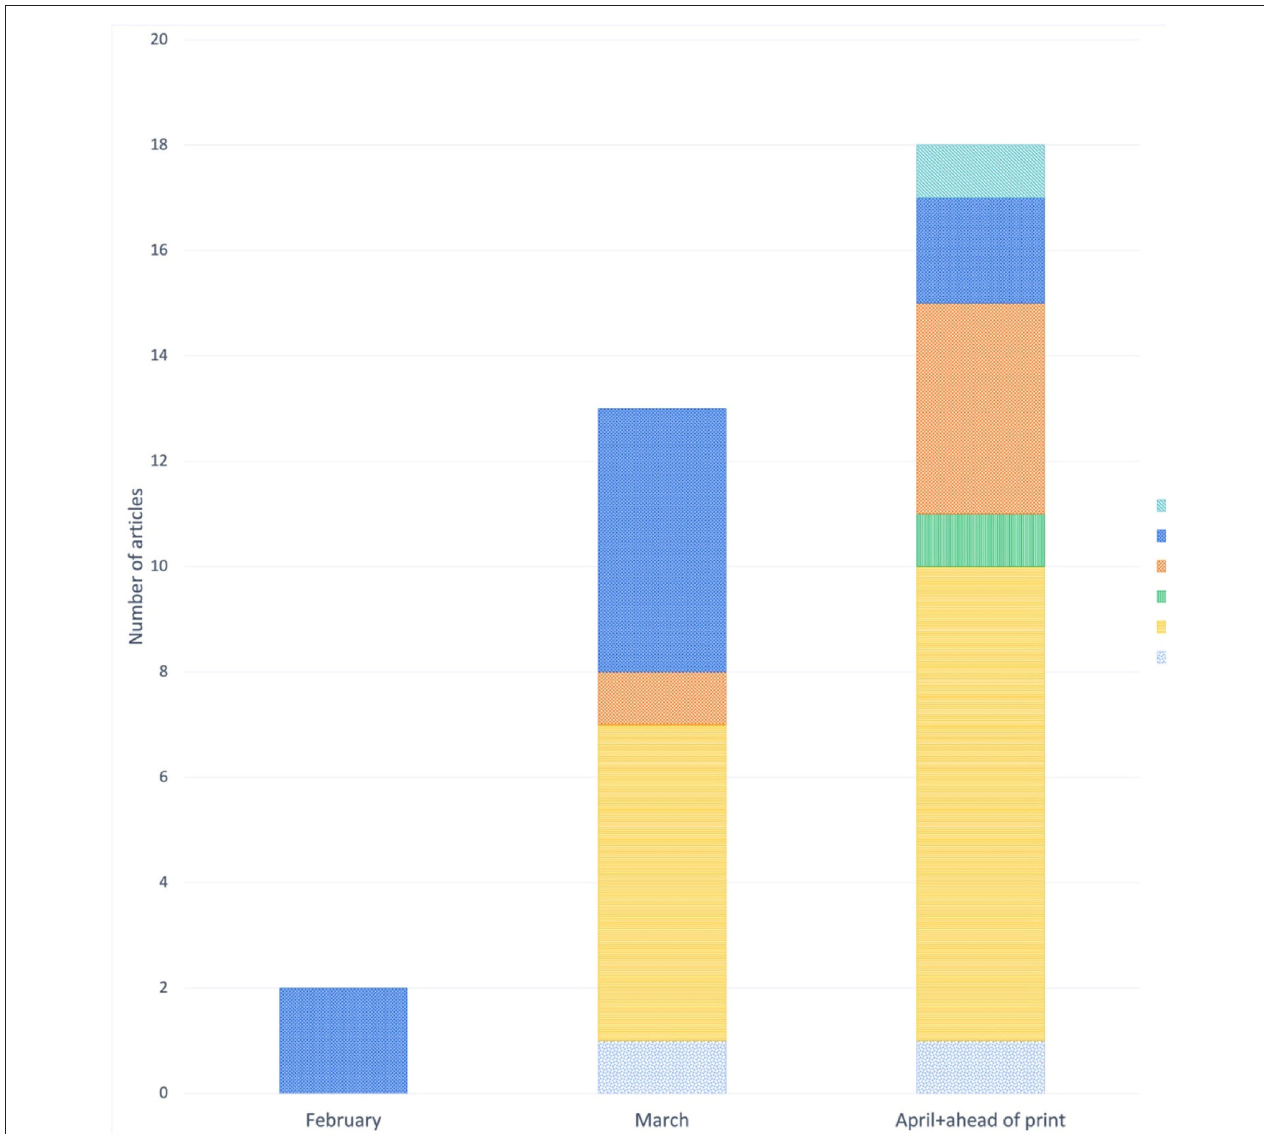
FIGURE 4 | Non-Italian articles published each month, by type of